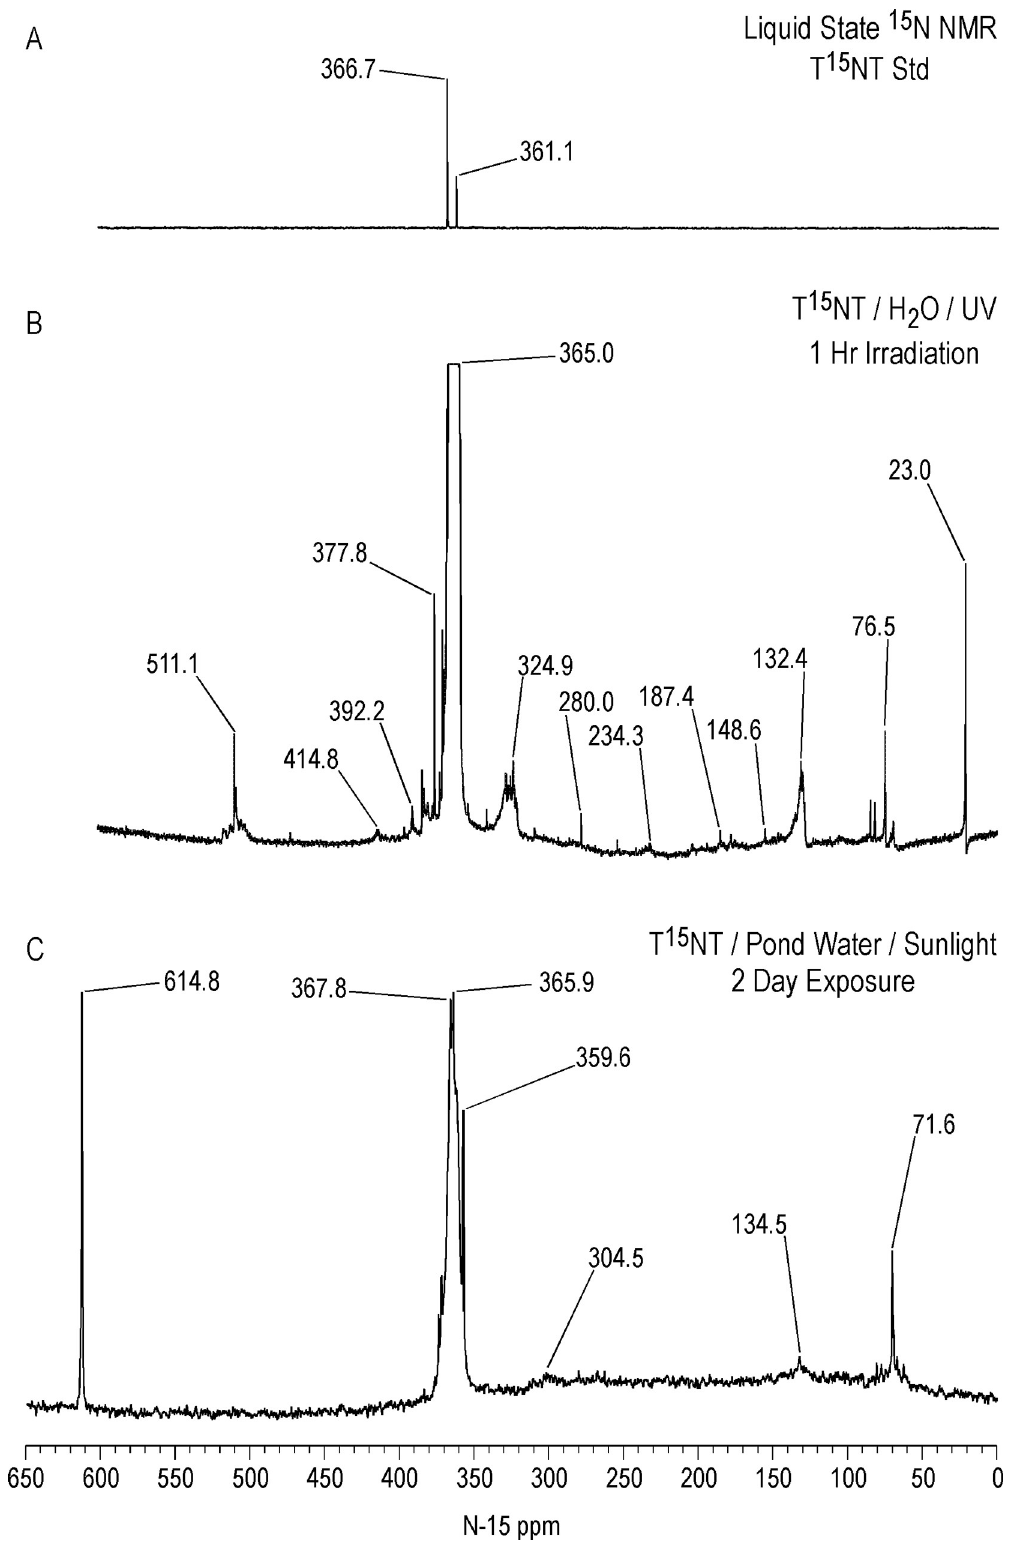
Fig 11. Liquid state IGD N-15 NMR spectra of T 15 NT. A. Standard. B. Lamp irradiation in deionized water. C. Sunlight irradiation in pond water. Line broadening = 3.0 Hz. https://doi.org/10.1371/journal.pone.0224112.g011 PLOS ONE | https://doi.org/10.1371/journal.pone.0224112 October 22,